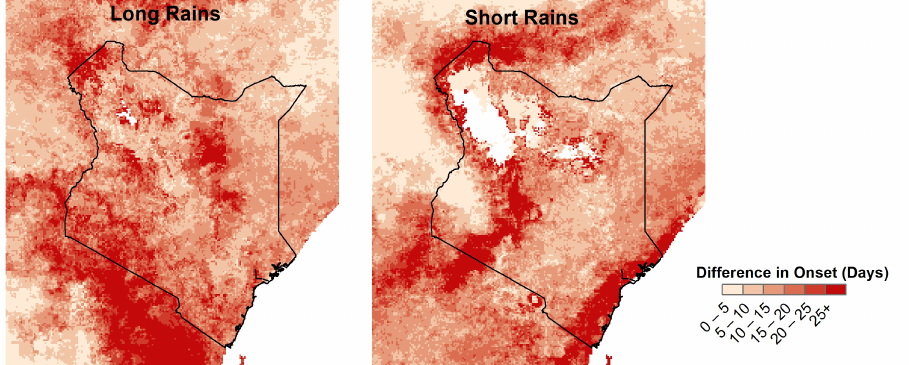
Figure 3. This image shows the average absolute difference in onset date between CHIRPS-GEFS and CHIRPS.